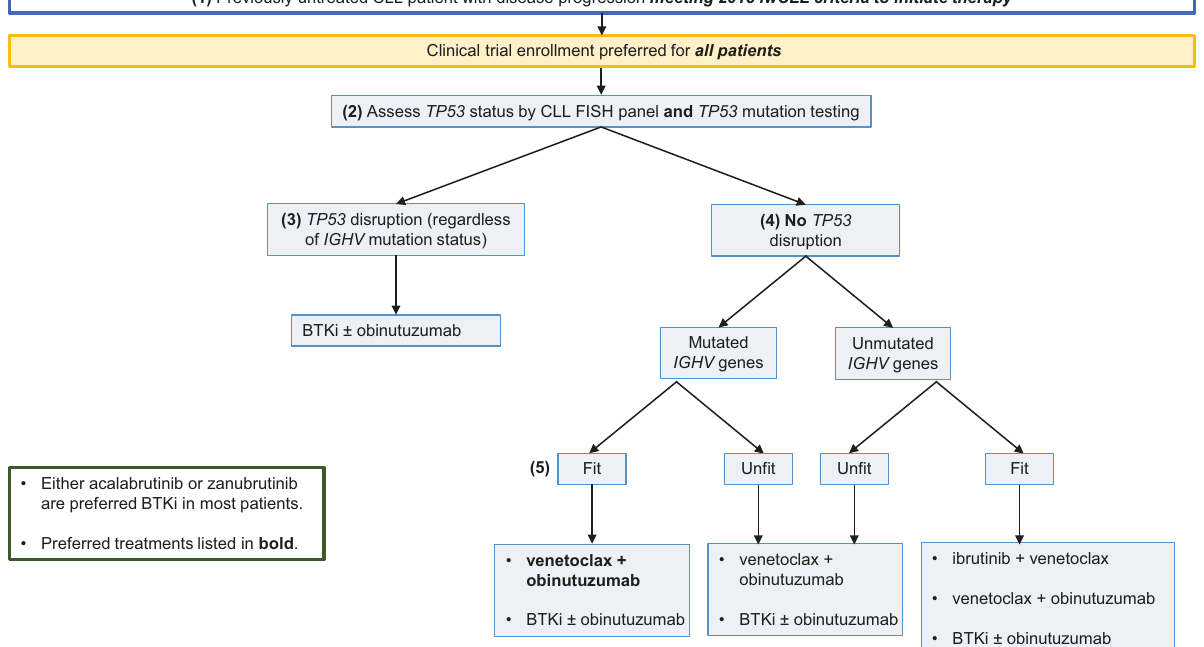
Fig. 3 Approach to the management of patients with previously untreated CLL who meet the 2018 International Workshop for Chronic Lymphocytic Leukemia (iwCLL) criteria for therapy. BTKi Bruton tyrosine kinase inhibitors, IGHV immunoglobulin heavy chain